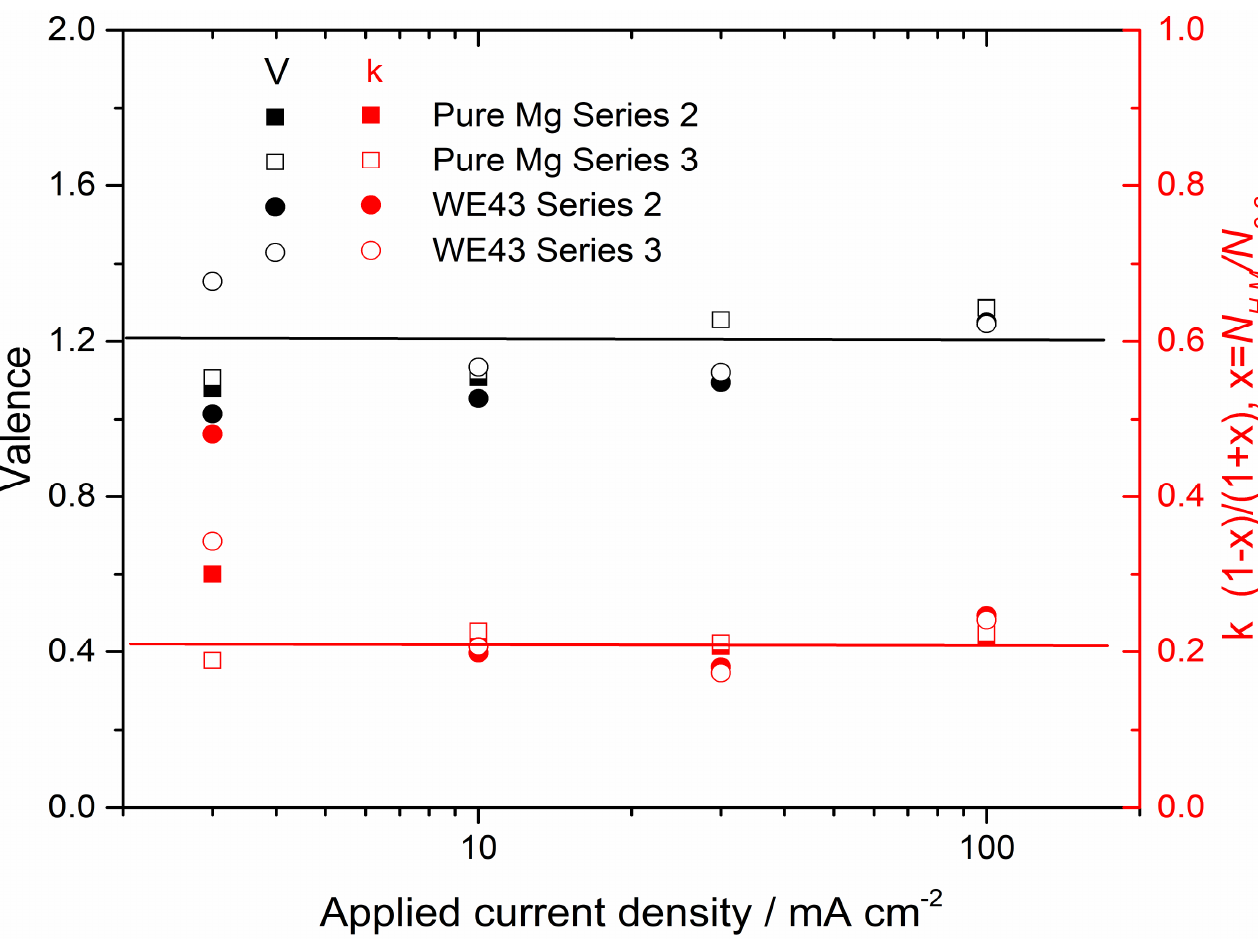
Figure 16. Plot of apparent Mg valence as evaluated from the experimental data of Li et al. [92]. The valence was evaluated as the number of electrons for each atom of Mg produced by the anodic partial reaction during the anodic polarization experiment. The experimental evidence indicates that there were 1.2 electrons per Mg atom. This value of apparent Mg valence V = 1.2 contradicts the assumption of the enhanced catalytic activity mechanism that assumes that V = 2.0.